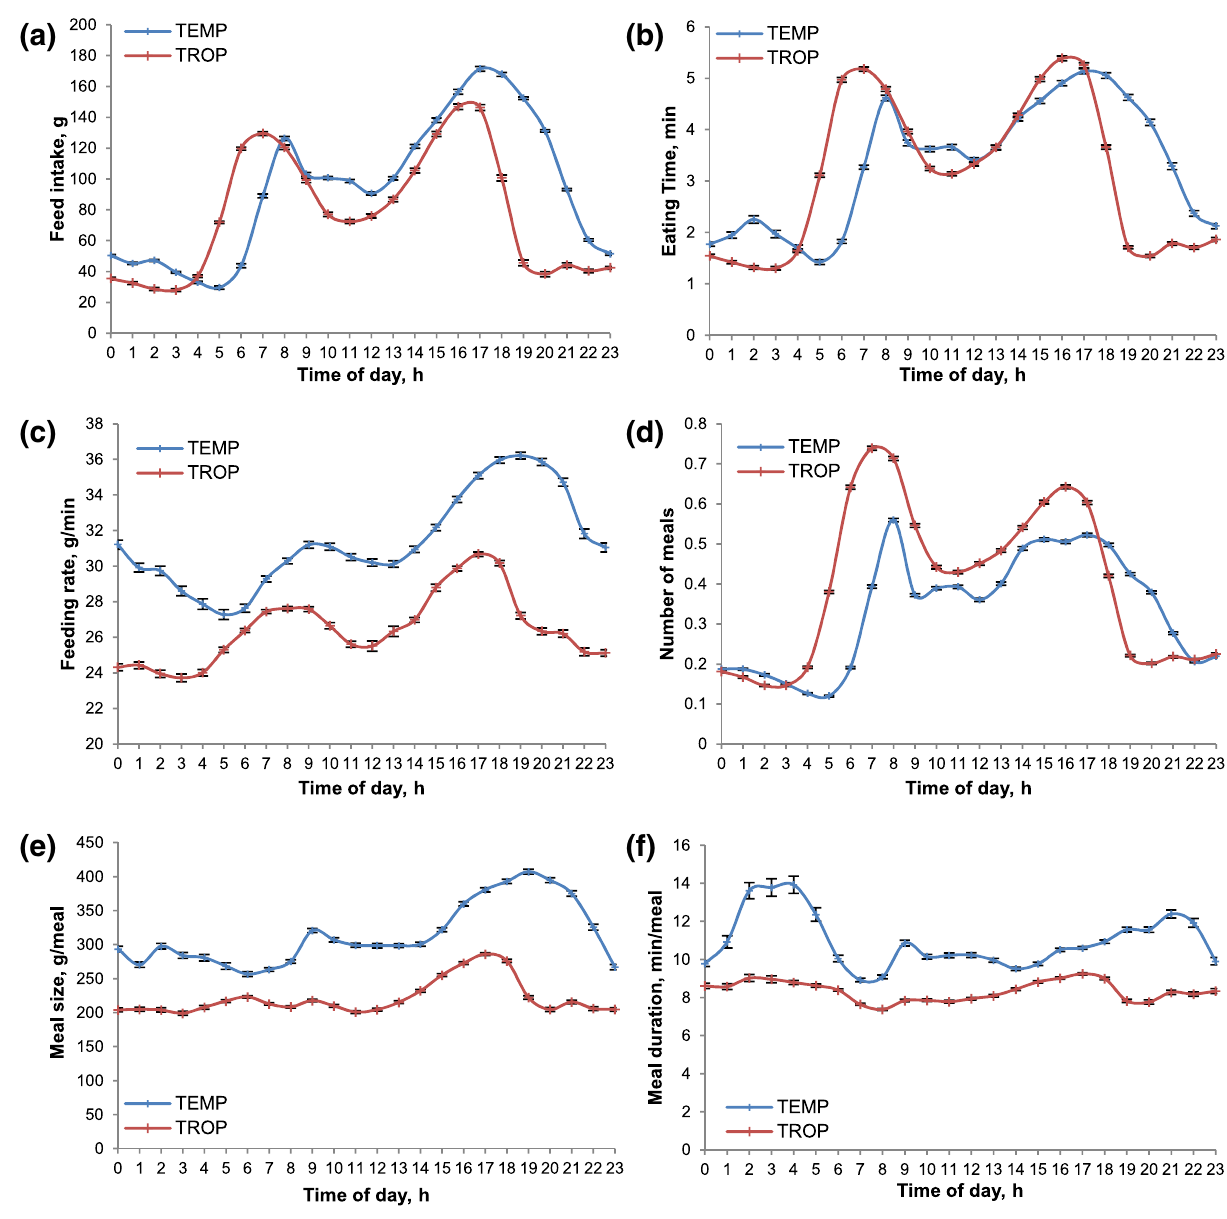
Figure 2. Hourly distribution of feeding parameters according to the production environment. Temperate (red, n = 634), tropical (blue, n = 662). ( a ) Feed intake, ( b ) time feeding, ( c ) feeding rate, ( d ) number of meals, ( e ) feed intake per meal, ( f ) time per meal. Error bars represent standard